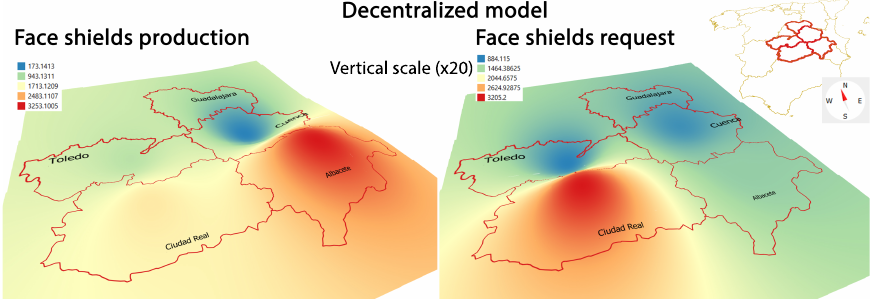
Figure 12. Flux map of the face shields production and delivery in the decentralized organizational model.